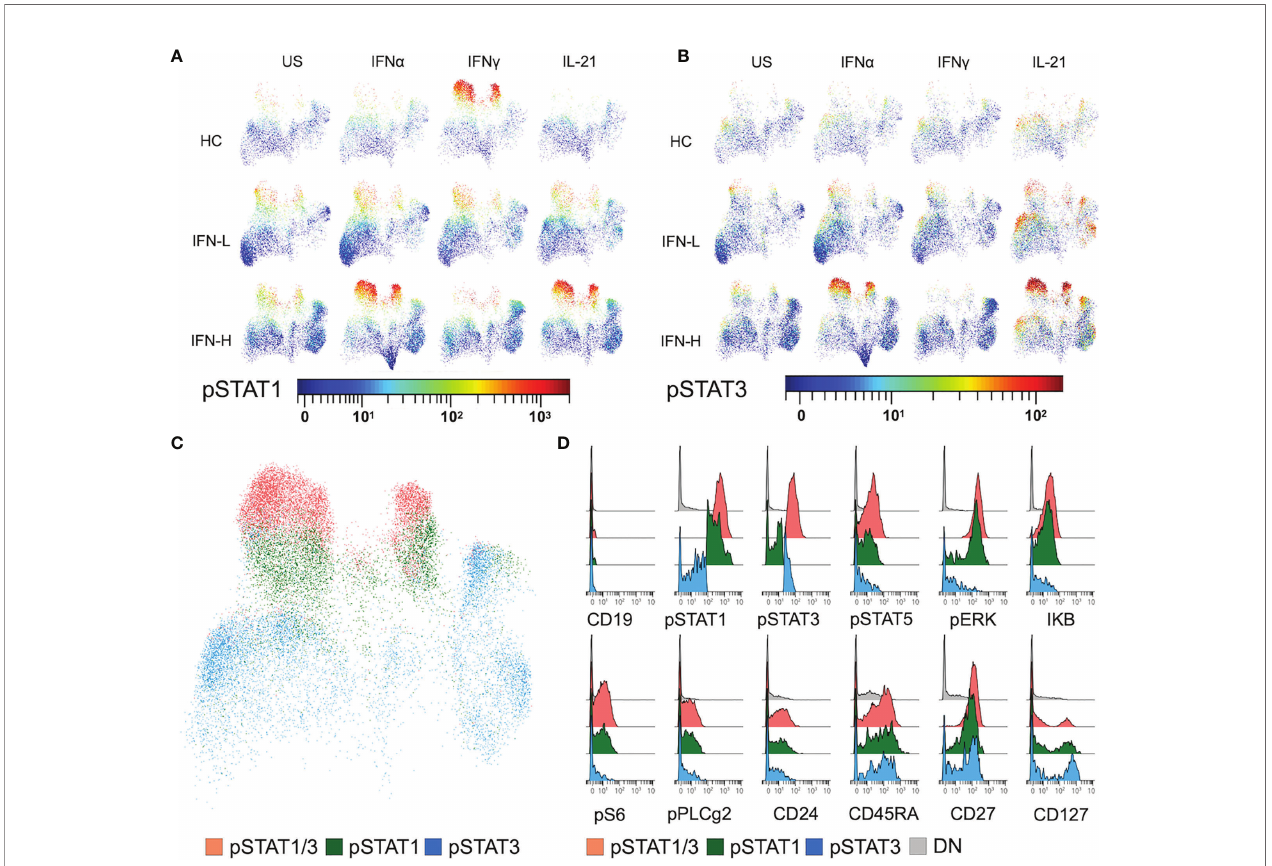
FIGURE 6 | (A-D) IFN signature associated with increased STAT1/3 phosphorylation in T cells expressing stress, proliferation, and co-stimulation proteins. (A, B) UMAP plots of T cells isolated from HC, IFN-L and IFN-H patients stimulated with IFN a , IFN g , IL-21 or unstimulated (US) colored by pSTAT1 (A) or pSTAT3 (B) intensity. (C) UMAP plot of T cells expressing pSTAT1 and 3 (orange), pSTAT1 (green), or pSTAT3 (blue). Plot of T cells from IFN-H samples stimulated with IFN a is representative of T cells from HC and IFN-L samples in all pTOF conditions. (D) Histograms displaying expression of both surface (CD19, CD24, CD27, and CD127) and intracellular signaling (pSTAT1, pSTAT3, pSTAT5, pERK, IKB, pS6, and pPLCg2) proteins of manually gated T cells expressing pSTAT1 and 3, pSTAT1, pSTAT3, or DN = double negative T cells, from IFN-H PBMCs stimulated with IFN a